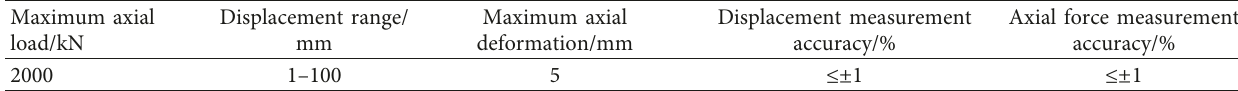
Table 1: Parameters of test machine.